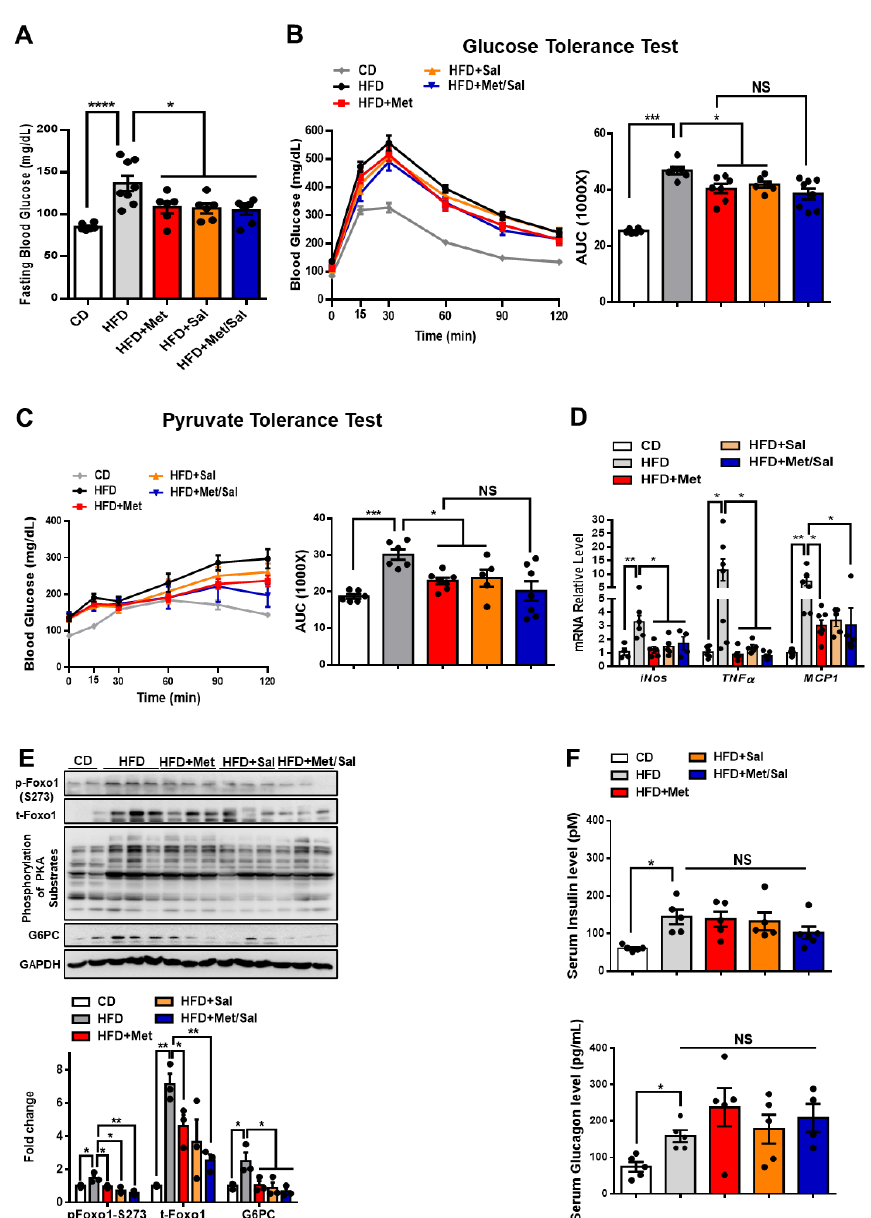
Figure 6. Metformin and salicylate improve glucose homeostasis in HFD-fed mice. ( A ) Fasting blood glucose level in HFD mice treated with metformin and salicylate for 7 weeks after 16 h fasting, n = 6–8 mice/group. ( B ) Glucose tolerance test in HFD mice treated with metformin and salicylate for 7 weeks, n = 6–8 mice/group. ( C ) Pyruvate tolerance test in HFD mice treated with metformin and salicylate for 7 weeks, n = 6–8 mice/group. ( D ) The mRNA expression levels of inflammatory factors in livers of 16 h overnight fasted HFD mice treated with metformin and salicylate for 7 weeks, n = 4–6 mice/group. ( E ) The protein levels of gluconeogenic genes in livers of 16 h overnight fasted HFD mice treated with metformin and salicylate for 7 weeks, n = 3 mice/group. ( F ) The insulin and glucagon levels in serum from HFD-fed mice treated with metformin and salicylate for 7 weeks, n = 4–5 mice/group. All data are presented as mean ± SEM. * p < 0.05, ** p < 0.01, *** p < 0.001, **** p < 0.0001. CD: chow diet. 3.6. The Effect of Metformin and Aspirin Combined Therapy on Blood Profiles in T2D Patients Patients with T2D were next recruited and treated with either metformin or com- bined metformin and aspirin (abbreviated hereafter as Group M and Group M + A). Both M and M + A groups exhibited improvement in blood glucose profile, which is indicated